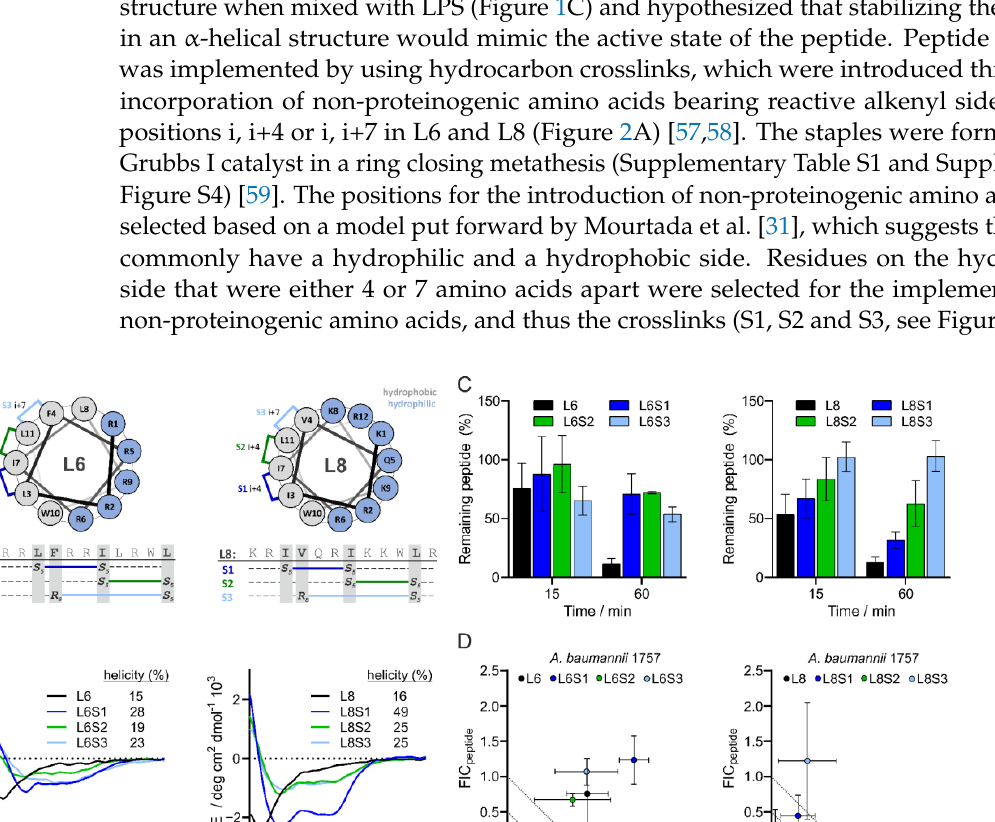
tides were diluted in human serum and peptide quantities over time were determined via HPLCU/MS. We observed that the unstapled peptides were least stable in human serum while L6S2 and L8S3 showed the highest stabilities (Figure 2C). 3.6. L8S2 Retains In Vitro Synergy with Vancomycin against A. baumannii We first tested the in vitro antimicrobial activity of the stapled peptides alone and in combination with vancomycin against clinical isolate A. baumannii 1757. The MIC values of the stapled L6 peptides were no more than 2-fold different to the unmodified peptide (Supplementary Table S5). On the other hand, the MIC values of the stapled L8 peptides showed greater variability, ranging from a 4-fold increase for L8S1 to a 25-fold improved MIC for L8S3 (Supplementary Table S5). Moreover, the synergistic activity of peptides upon combination with vancomycin showed large differences. For example, peptide L8S2 retained a synergistic effect, similar to L8 (Figure 2D), whereas the stapled L8S1 and L8S3 lost their potentiating activity (Figure 2D).